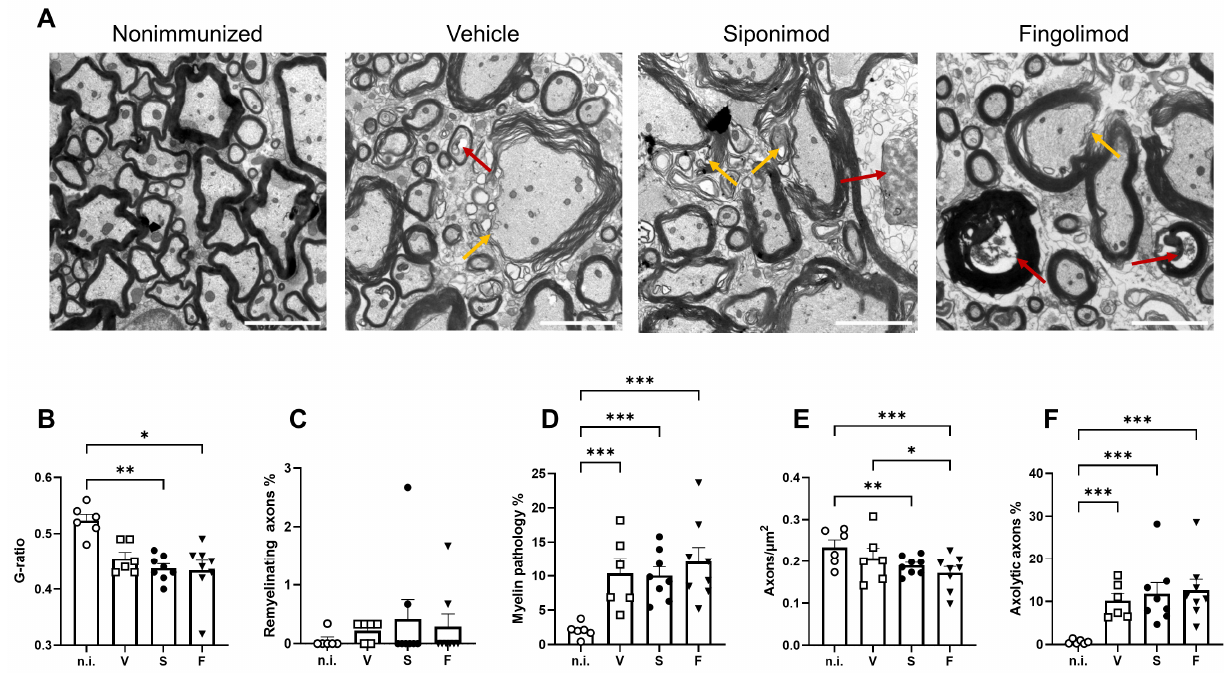
Figure 8. Transmission electron microscopy analysis of the spinal cord of siponimod- or fingolimod- treated experimental autoimmune encephalomyelitis (EAE) mice. ( A ) Representative images of all treatment groups. Red arrows indicate axolytic axons, and yellow arrows indicate myelin pathology. Scale bars represent 2 µm. Quantification of the ( B ) g-ratio, ( C ) percentage of axons with pathological myelin, ( D ) percentage of remyelinating axons, ( E ) axons/µm 2 , and ( F ) percentage of axons undergoing axolysis. Statistical analysis was performed using one-way ANOVA with either Tukey’s (myelin pathology, axons/µm 2 , and axolytic axons) or the Kruskal–Wallis (g-ratio and remyelinating axons) post hoc test. * p < 0.05; ** p < 0.01; *** p < 0.001. EAE = experimental autoimmune encephalo- myelitis, n.i. = nonimmunized, S = siponimod, F = fingolimod, V = vehicle, ANOVA = analysis of variance.